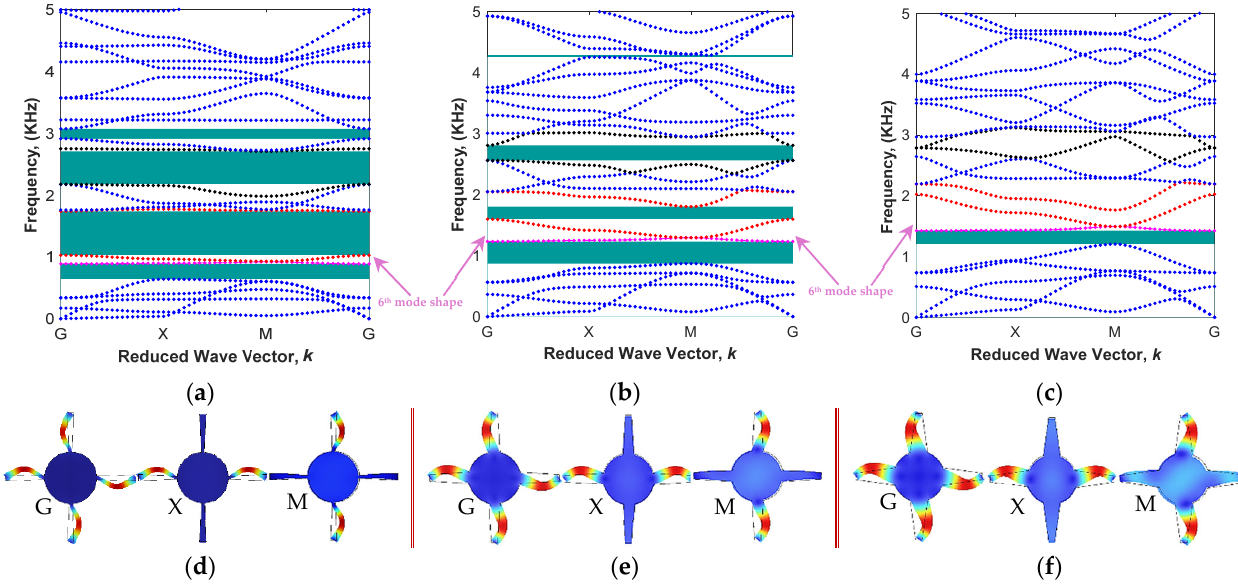
Figure 6. Various band structures in different arm angles with the fixed cylindrical core radius of L / R = 5 and MRE with iron volume fraction of 13.94%: ( a , d ) θ = − 1.5 ◦ ; ( b , e ) θ = + 3.5 ◦ ; ( c , f ) θ = + 8 ◦ , as well as the sixth mode shapes of the structures in high symmetry points (Sixth mode shape colored in purple represents the first band gap; Seventh and eighth mode shapes colored in red and represent the second band gap; Eleventh and twelfth mode shapes colored in black and represent the third band